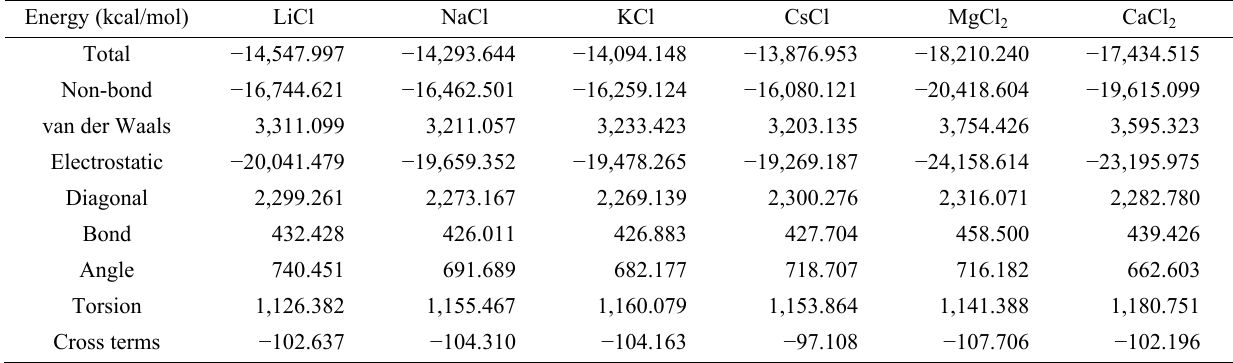
Fig. 8 3D periodic structure models in different inorganic salt solutions: (a) LiCl solution and PVPA, (b) NaCl solution and PVPA, (c) KCl solution and PVPA, (d) CsCl solution and PVPA, (e) MgCl 2 solution and PVPA, and (f) CaCl 2 solution and PVPA. Table 2 System energy after structural